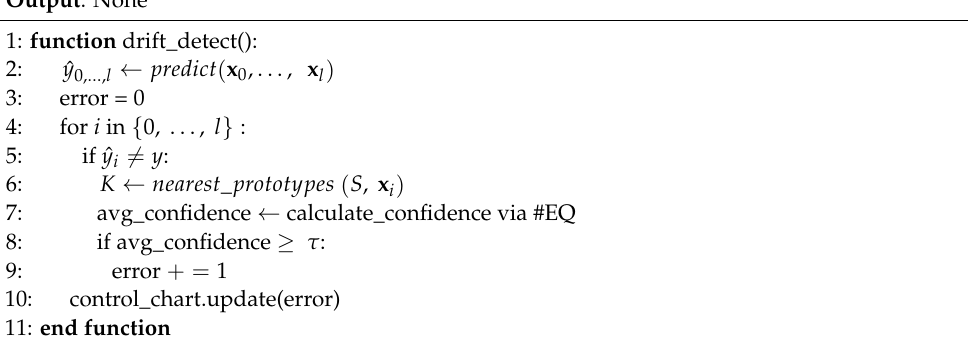
Algorithm 2: Confidence Region Prediction Conflict Concept Drift